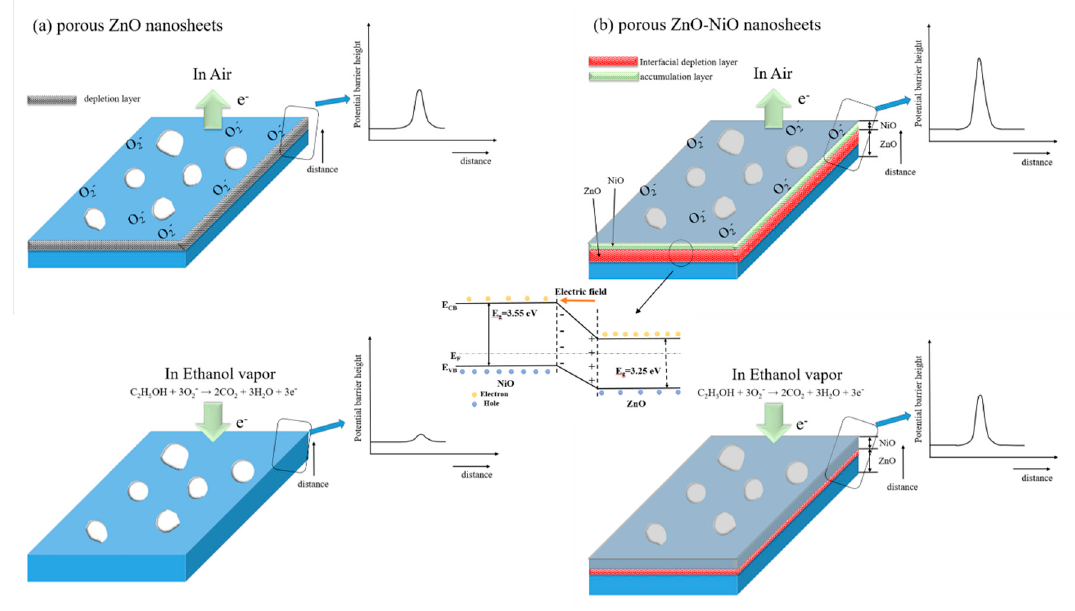
Figure 6. Schematics of possible ethanol vapor-sensing mechanisms of the ( a ) porous ZnO nanosheet and ( b ) porous ZnO-NiO composite nanosheet.